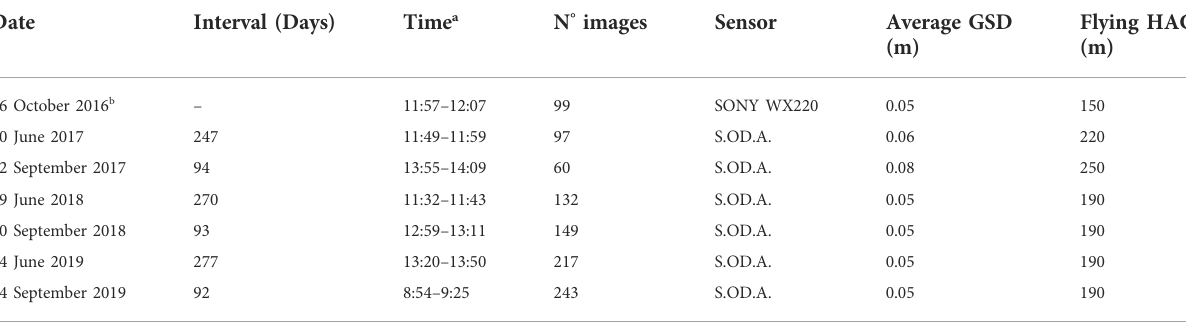
TABLE 1 Details of the UAV surveys of Tsarmine rock